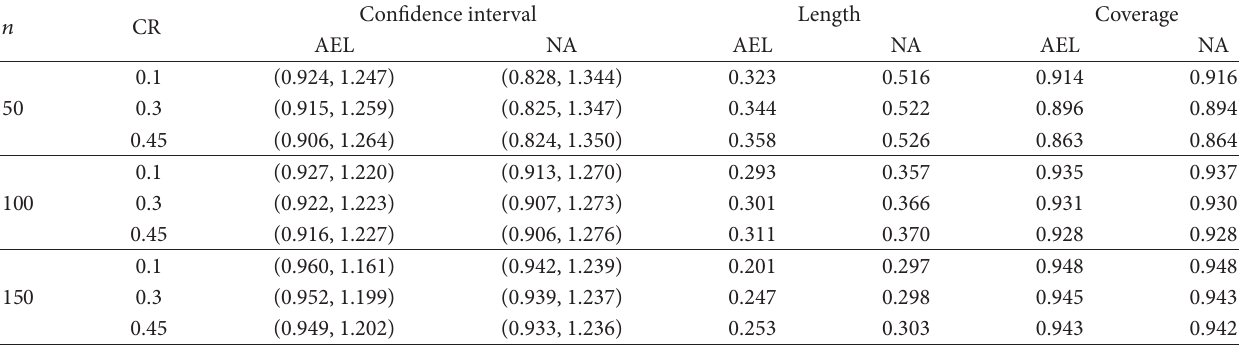
T 1: e average lengths and coverage probabilities of the 95